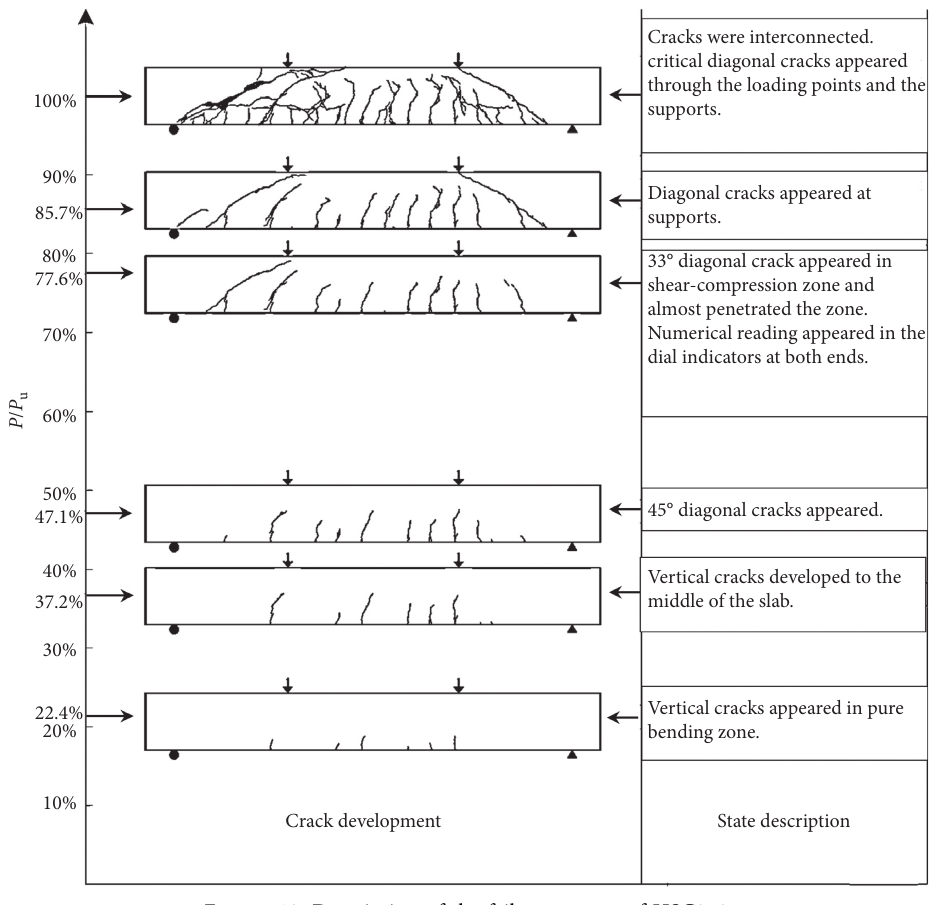
Figure 13: Description of the failure process of HSC2-6.